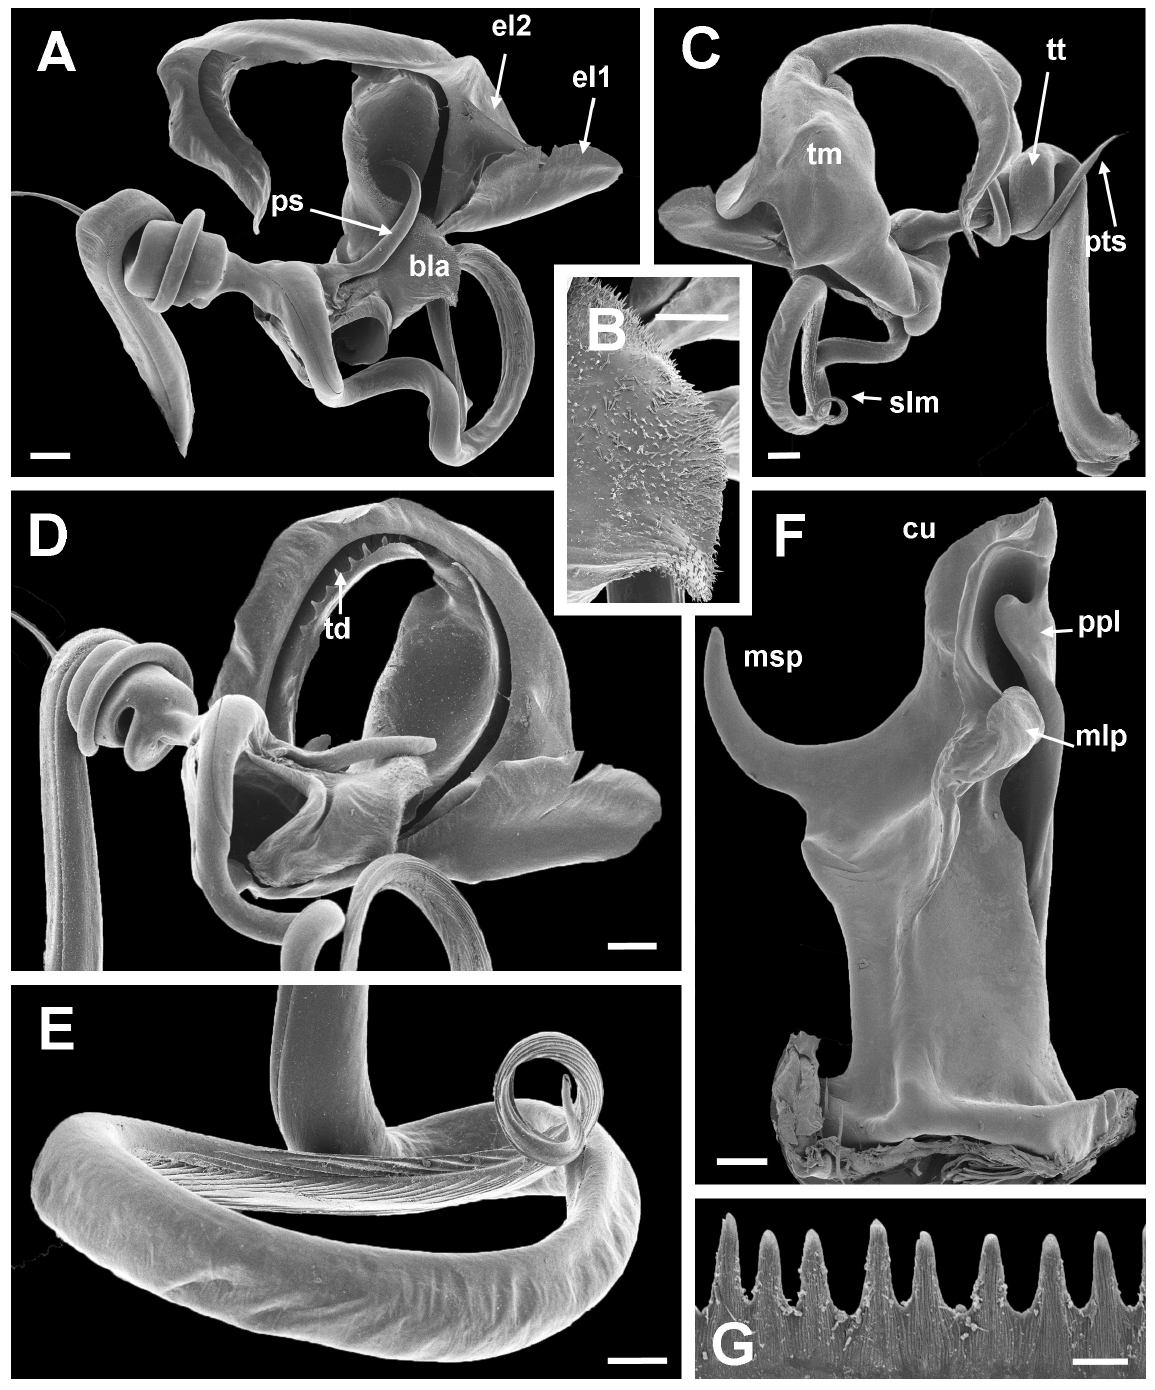
Fig. 9. Spinotarsus fortehamatus sp. nov., holotype. A–E . Right gonopod telopodite. A . Posterior view. B . Basal lamella of telomere, enlarged. C . Anterior view. D . Posterior-mesal view. E . Distal part of solenomere. F . Right gonopod coxa, posterior and slightly mesal view. G . Limbus. Abbreviations: bla = basal lamella of telomere; cu = cucullus; el1 , el2 = smooth telomeral lamellae; mlp = metaplical lamellar process; msp = metaplical spine-like process; ppl = proplical lobe; ps = proximal solenomeral spine; pts = post-torsal spine; slm = solenomere; td = telomeral denticles; tm = telomere; tt = torsotope. Scale bars: A, C–D, F = 0.2 mm; B, E = 0.1 mm; G = 0.01